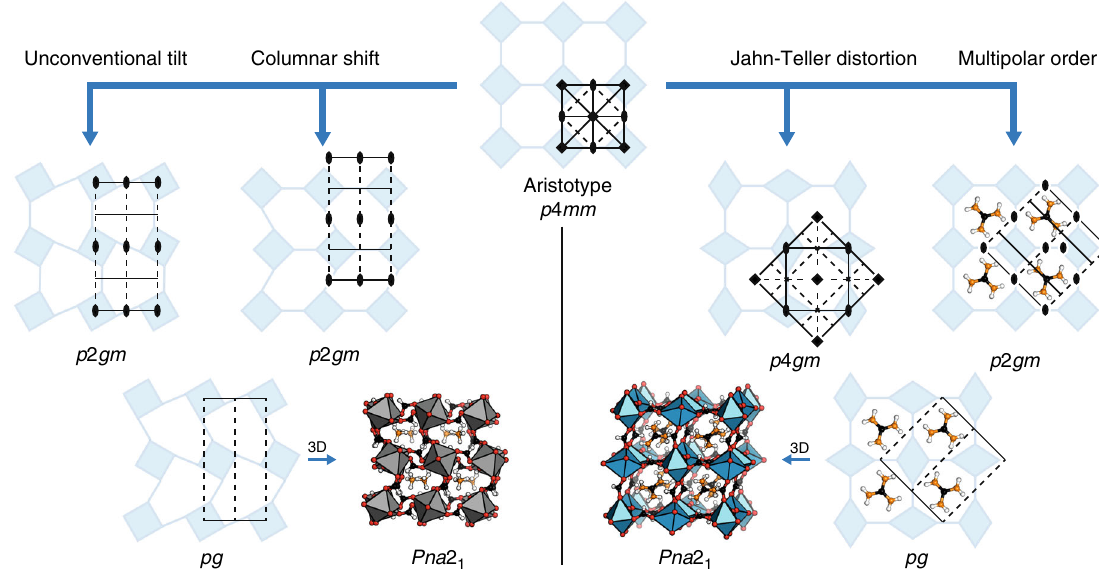
Fig. 3 Inversion symmetry breaking in 2D molecular perovskites. Left: both unconventional tilting and columnar shifts yield the plane group p 2 gm , but with different origins. When coupled together, the resulting plane group is pg , which lacks inversion symmetry. A conceptually related combination of octahedral tilts and shifts is responsible for inversion symmetry breaking in [NH 4 ]Cd(HCOO) 3 , which crystallises in Pna 2 1 . Right: a C -type cooperative Jahn – Teller distortion lowers 2D molecular perovskite symmetry to p 4 gm , whereas antiferrohexapolar order gives a p 2 gm cell with a different origin. When combined, the two distortions generate the polar plane group pg . This is a 2D analogue of the hybrid coupling found in GuaCu(HCOO)